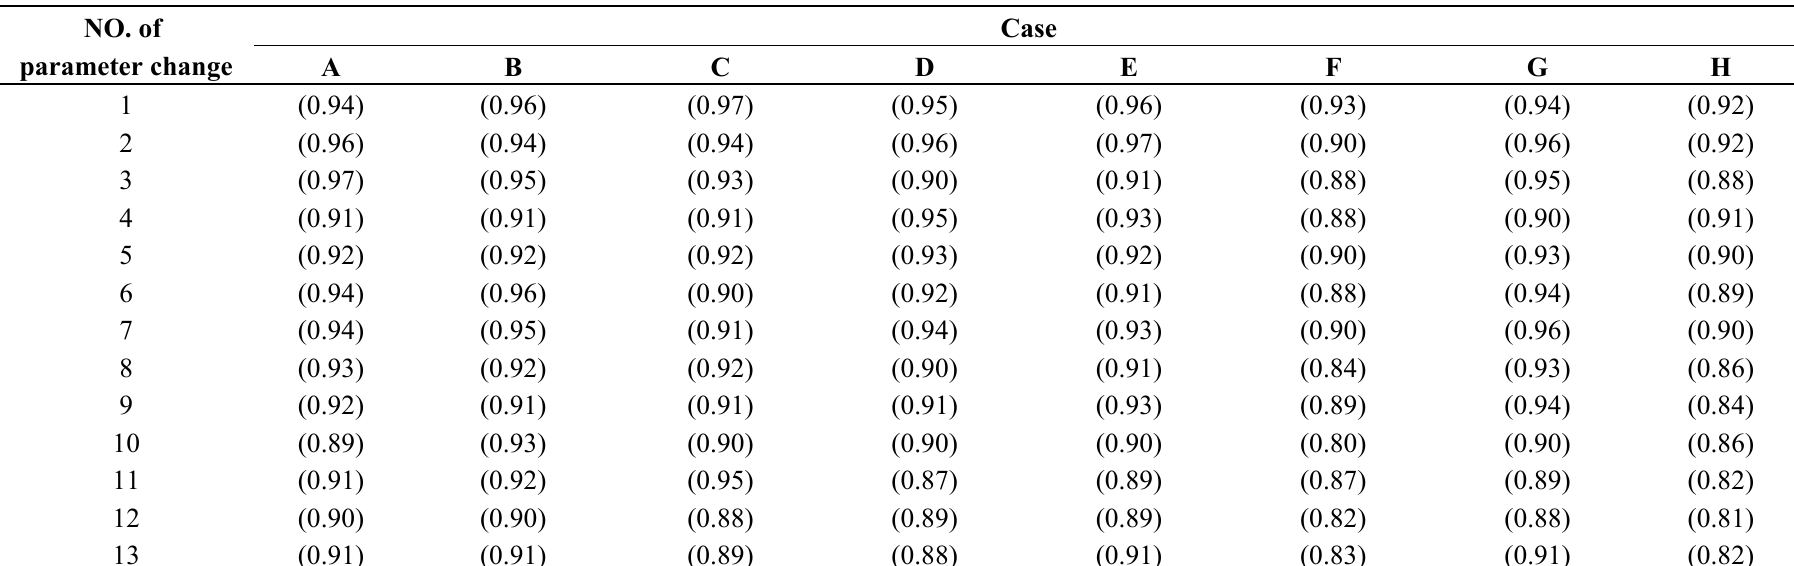
Table 14. Correlation coefficient result of EP